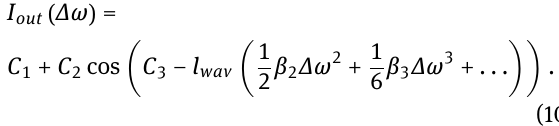
Fig. 4. The fringes recorded by the optical spectrum analyzer after the interferometer (red: recorded fringes; blue: fitted theoretical fringe pattern). The fringes allow to extract the dispersion profile of the waveguide. Adapted from reference [19].